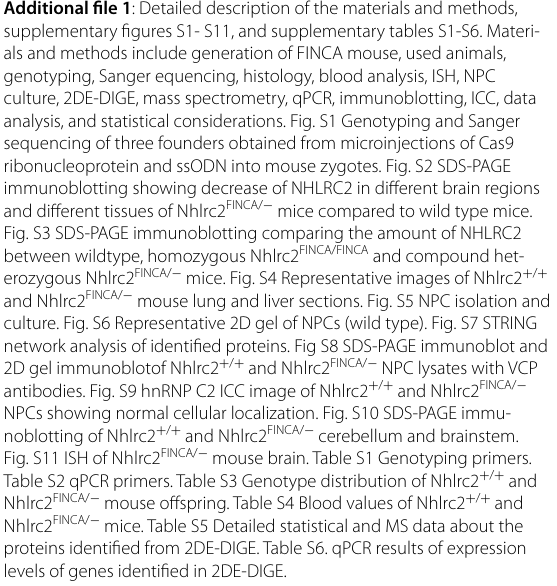
Fig. S3 SDS-PAGE immunoblotting comparing the amount of NHLRC2 between wildtype, homozygous Nhlrc2 FINCA/FINCA and compound het- erozygous Nhlrc2 FINCA/ − mice. Fig. S4 Representative images of Nhlrc2 + / + and Nhlrc2 FINCA/ − mouse lung and liver sections. Fig. S5 NPC isolation and culture. Fig. S6 Representative 2D gel of NPCs (wild type). Fig. S7 STRING network analysis of identified proteins. Fig S8 SDS-PAGE immunoblot and 2D gel immunoblotof Nhlrc2 + / + and Nhlrc2 FINCA/ − NPC lysates with VCP antibodies. Fig. S9 hnRNP C2 ICC image of Nhlrc2 + / + and Nhlrc2 FINCA/ − NPCs showing normal cellular localization. Fig. S10 SDS-PAGE immu- noblotting of Nhlrc2 + / + and Nhlrc2 FINCA/ − cerebellum and brainstem. Fig. S11 ISH of Nhlrc2 FINCA/ − mouse brain. Table S1 Genotyping primers. Table S2 qPCR primers. Table S3 Genotype distribution of Nhlrc2 + / + and Nhlrc2 FINCA/ − mouse offspring. Table S4 Blood values of Nhlrc2 + / + and Nhlrc2 FINCA/ − mice. Table S5 Detailed statistical and MS data about the proteins identified from 2DE-DIGE. Table S6. qPCR results of expression levels of genes identified in 2DE-DIGE. Additional file 2 : Unedited full images of the immunoblots for Fig. 2, Fig. 4, Fig. S2, Fig. S3, Fig S8, and Fig